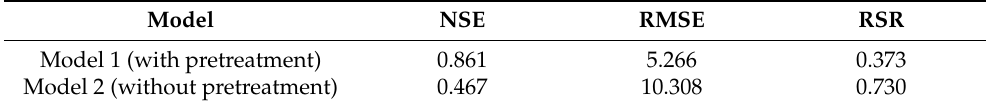
Table 5. Summary of the model evaluation